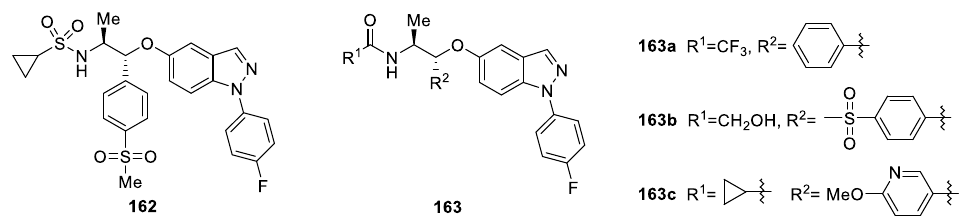
Figure 47. Chemical structures of 1 H -indazole ether derivatives 162 and 163a – c .